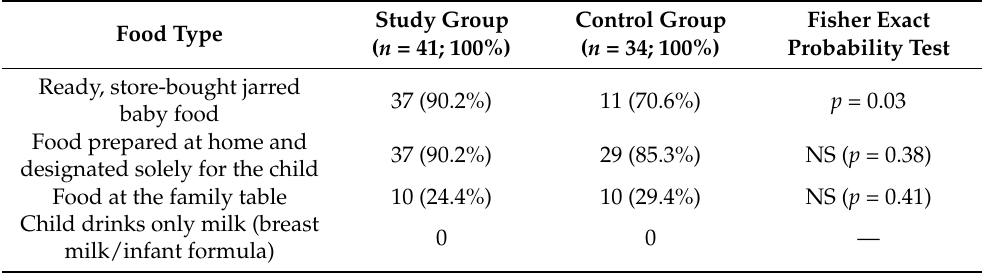
Table 6. What type of complementary food was introduced to child’s died in the study group and the control group (question